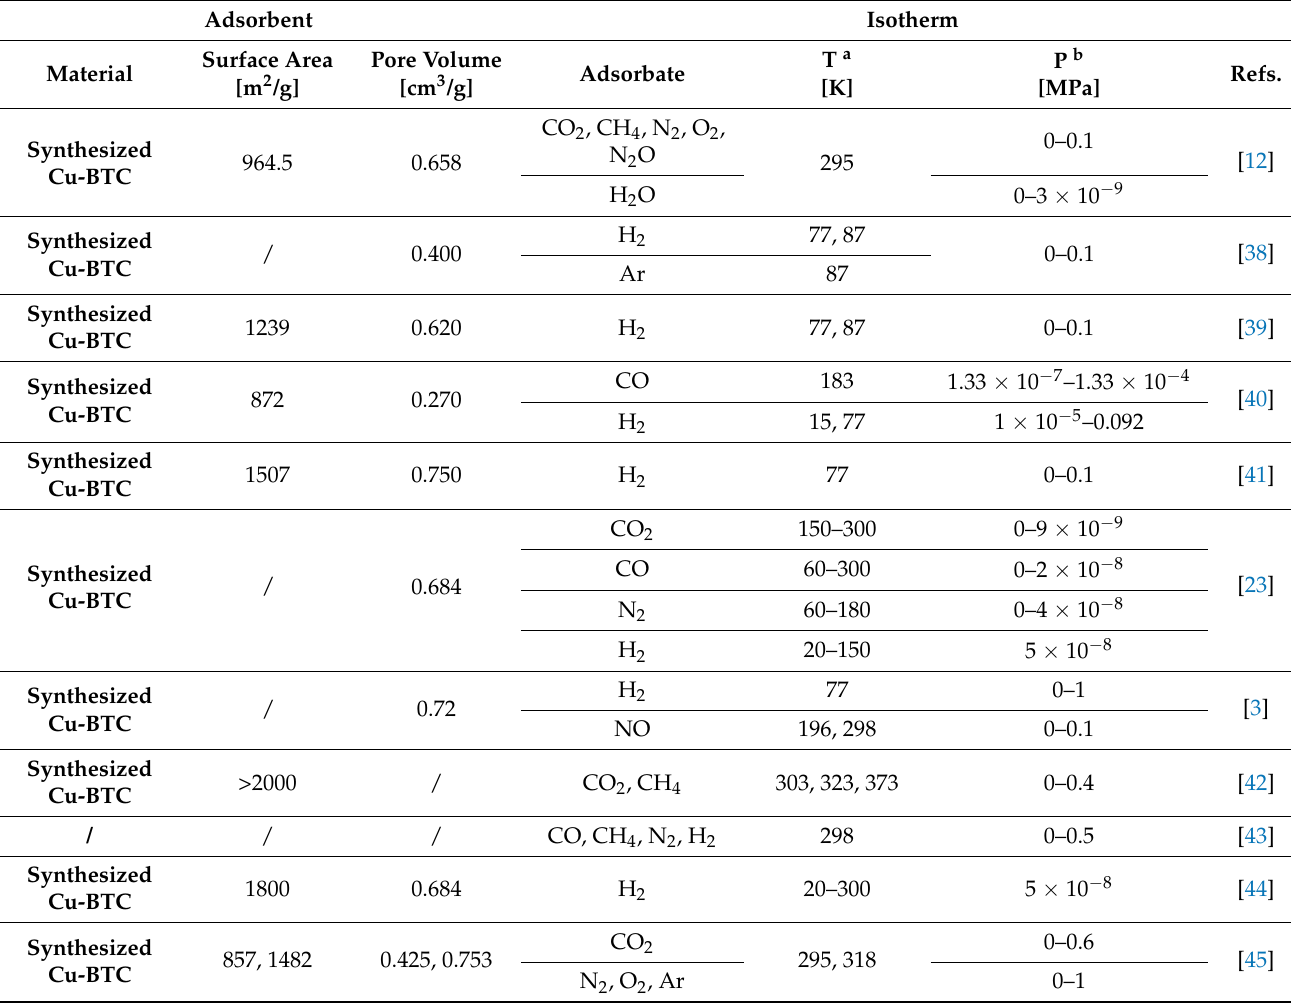
Table 1. Morphological features of the adsorbent materials and operating conditions of the adsorbates of interest retrieved from the